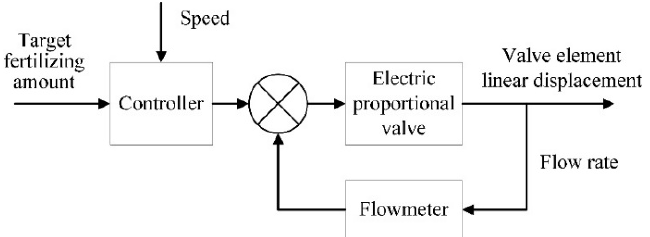
Figure 2. Block diagram of liquid fertilizer variable-rate rate fertilization control system. According to the input and output relationship of the control system block diagram,